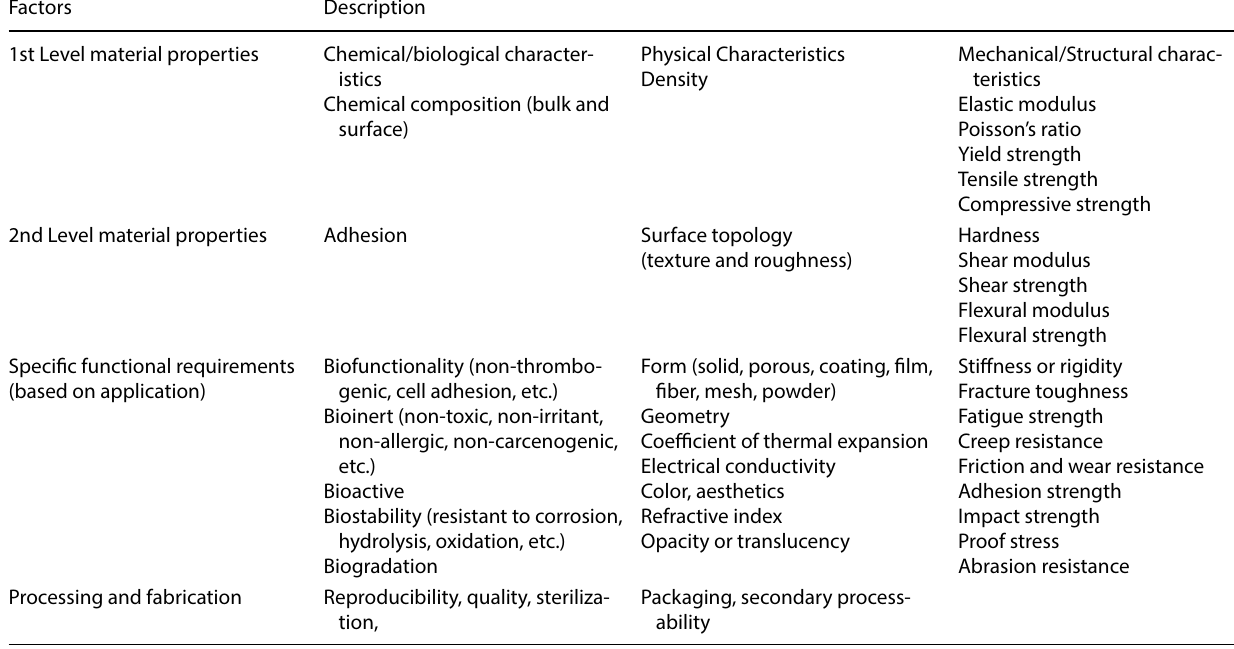
Characteristics of host: tissue, organ, species, age, sex, race, health condition, activity, systemic response Medical/surgical procedure, period of application/usage